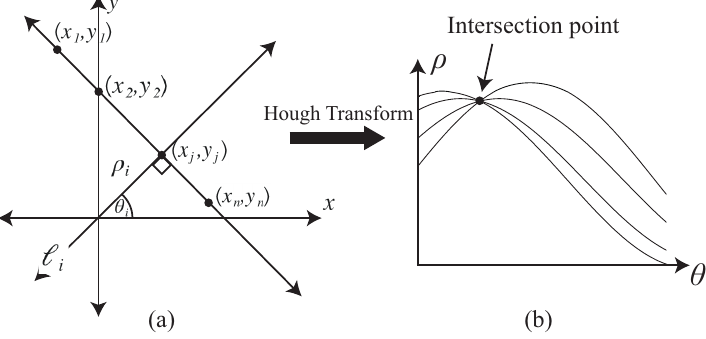
Figure 4. Relation of rectangular to polar representation of a line. ( a ) Cartesian axis. ( b ) Hough